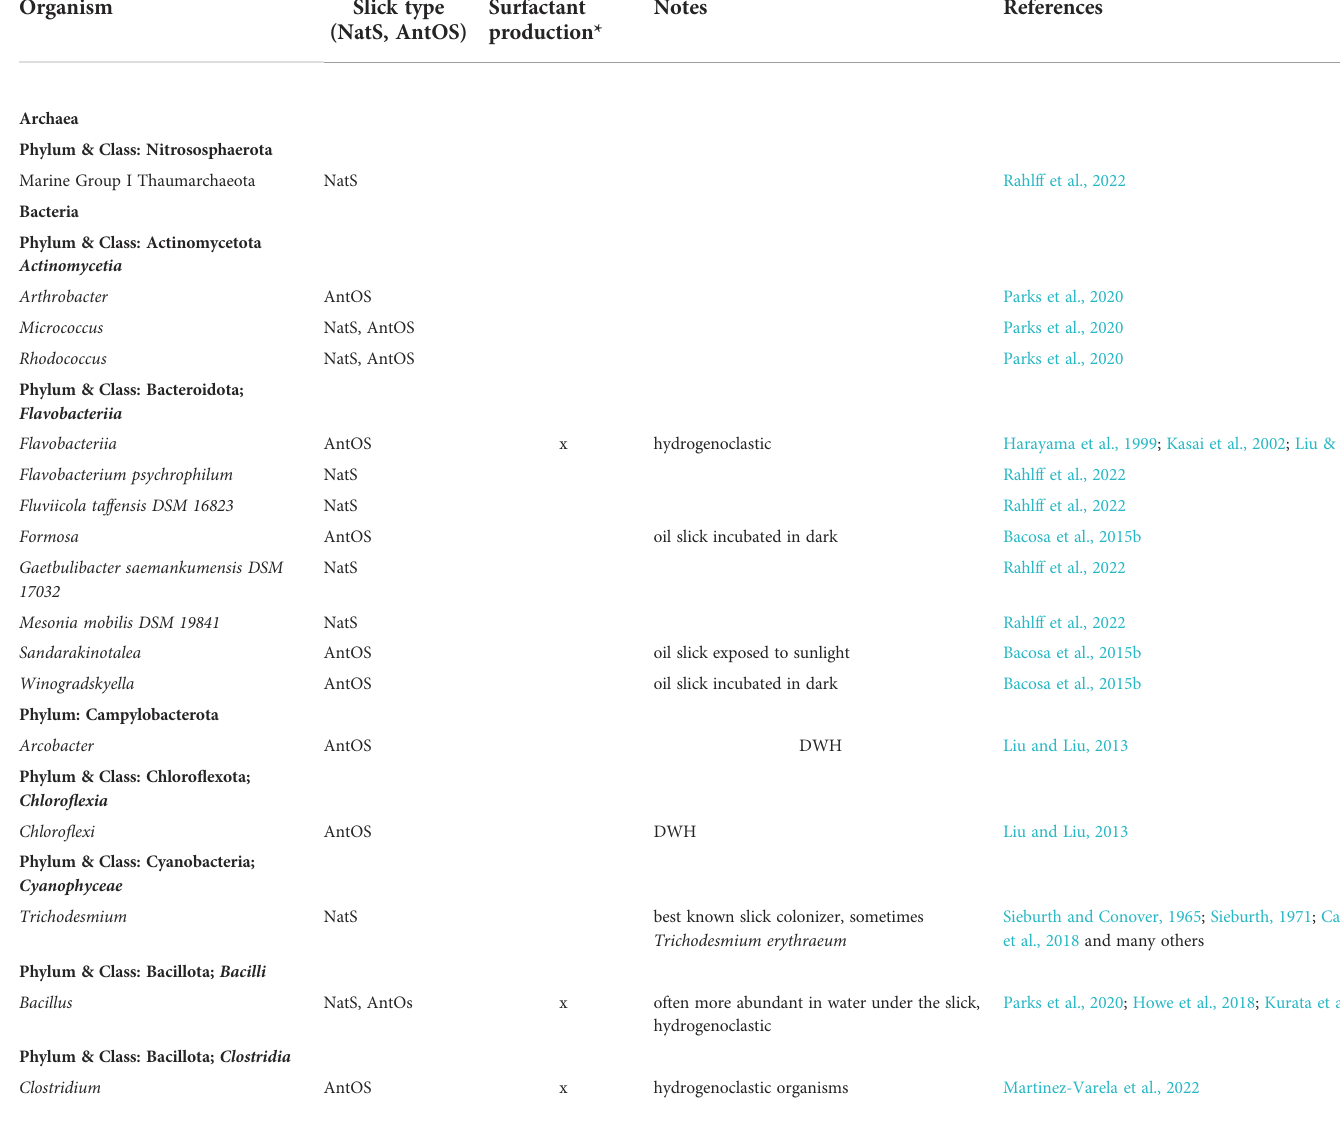
TABLE 1 Bacteria and archaea typically associated with natural slicks (NatS) and anthropogenic oil slicks (AntOS).